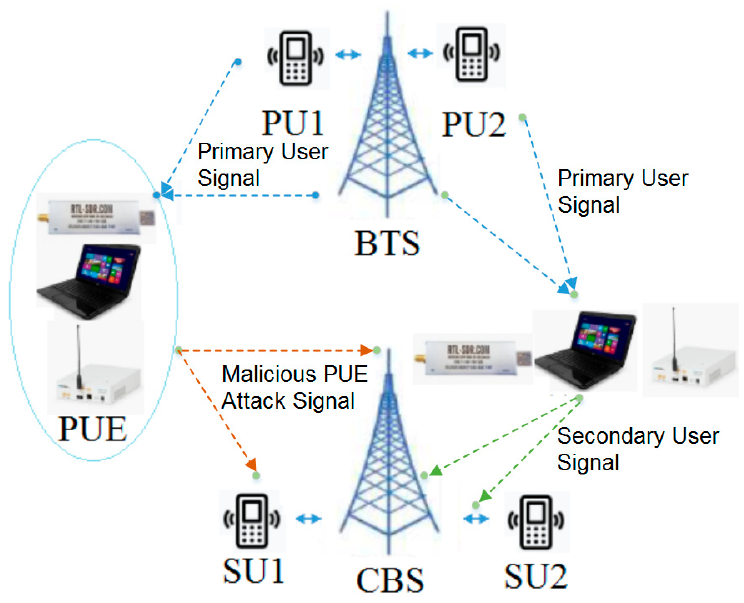
Figure 4. Software-defined radio ( SDR) testbed for experiments.